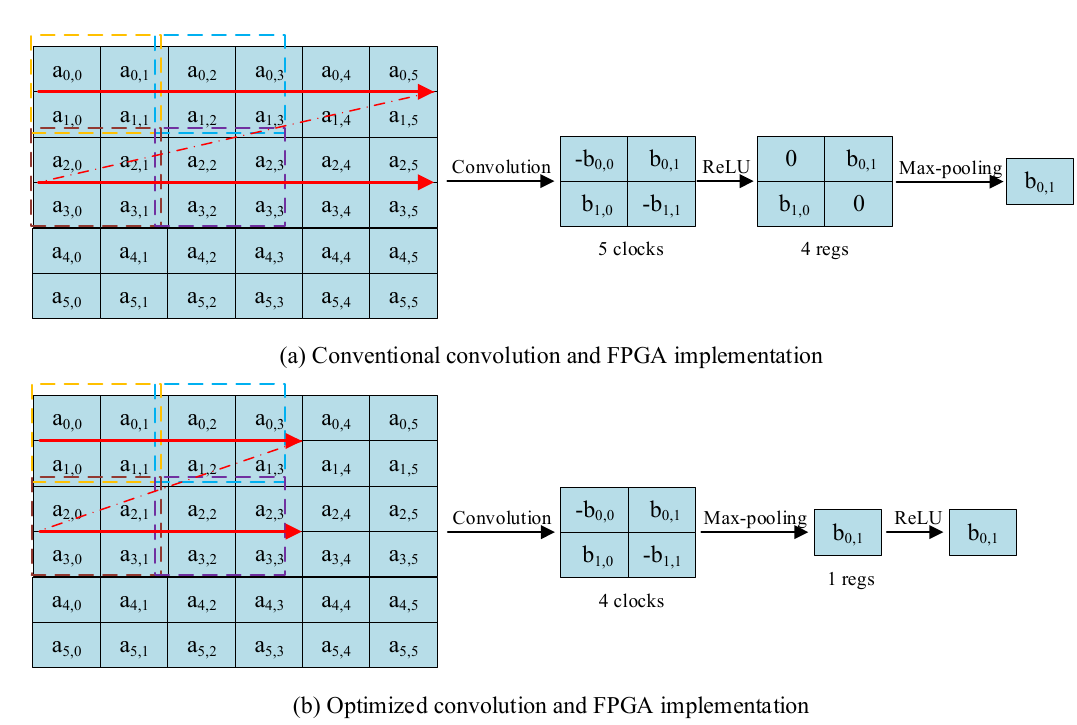
Figure 12. Optimization of the convolution calculation and FPGA implementation.